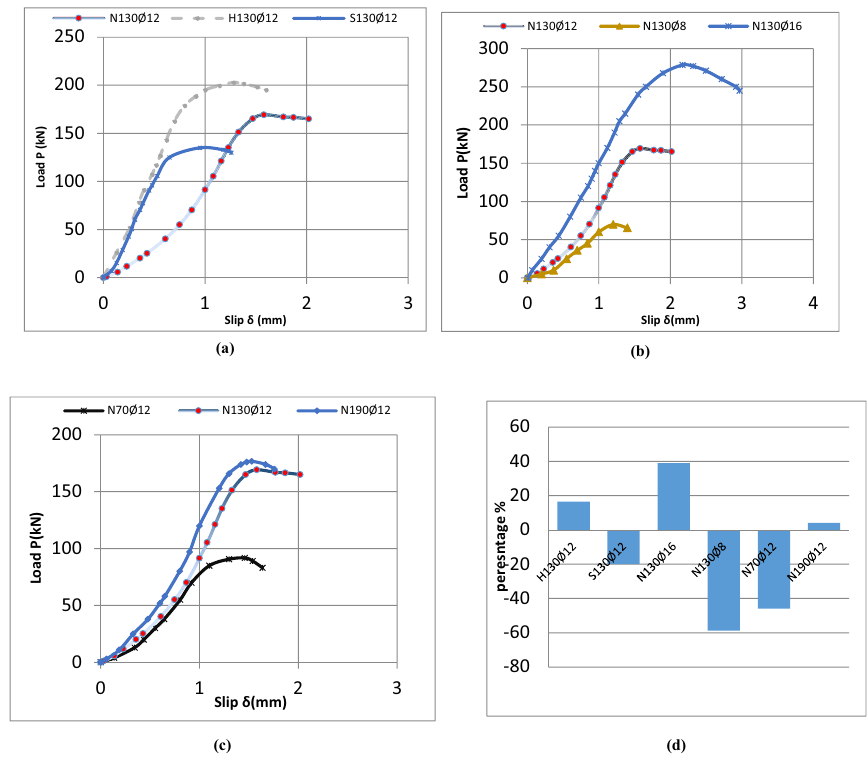
Figure 5: Load – slip curves of pushout rough surface specimens. ( a ) Alteration strength of new concrete, ( b ) alteration diameters of bolts, ( c ) alteration embedded length, and ( d ) percentage of di ff erences between rough surface specimens with reference model